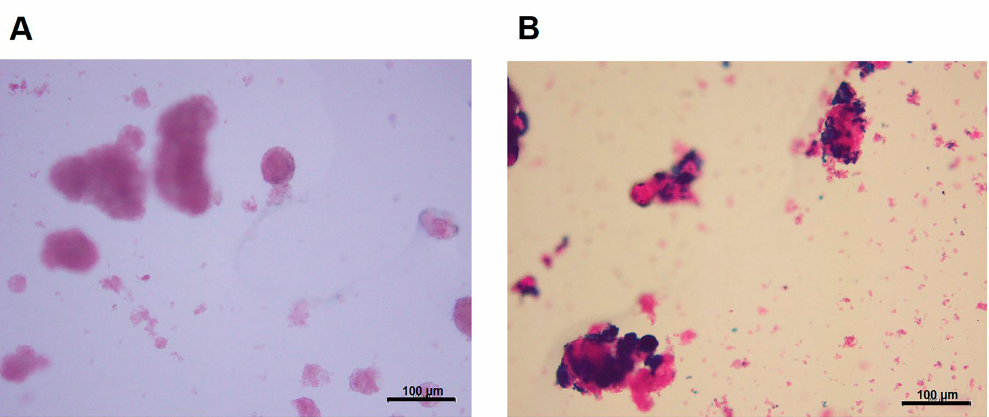
Figure 1. Uptake of chitosan-coated superparamagnetic iron oxide (CSPIO) nanoparticles by NPCCs. NPCCs were incubated overnight without ( A ) or with ( B ) CSPIO nanoparticles. The intracellular iron content was examined by Prussian blue